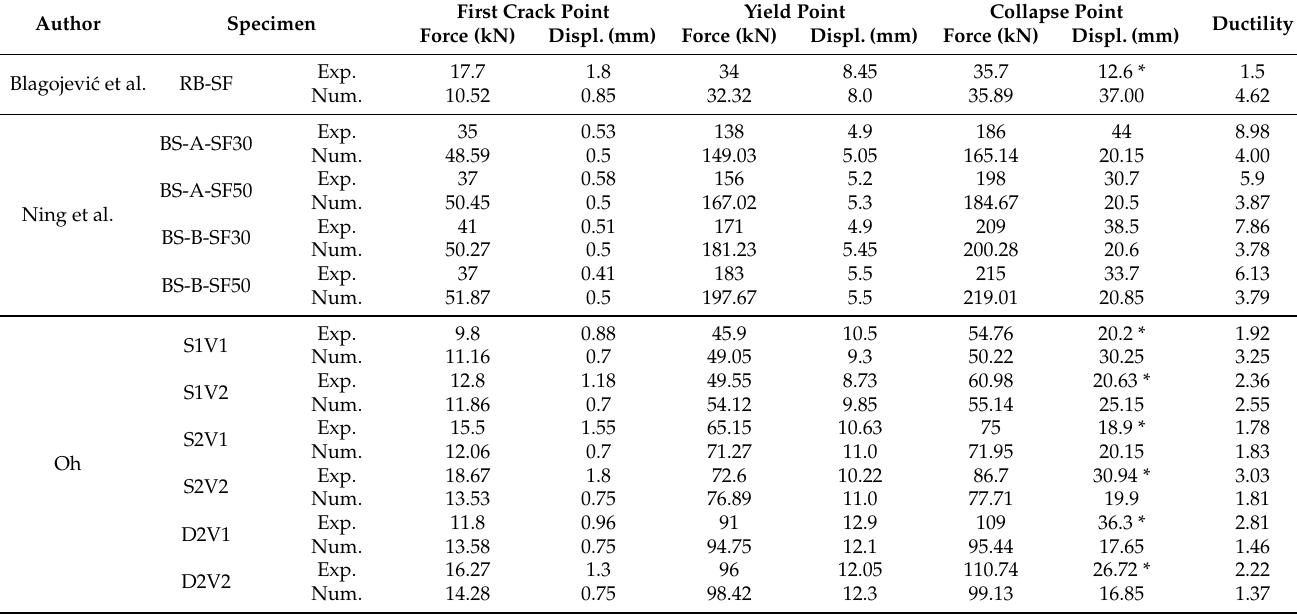
Table A2. Comparison of numerical and experimental results for three characteristic points used for numerical model validation.